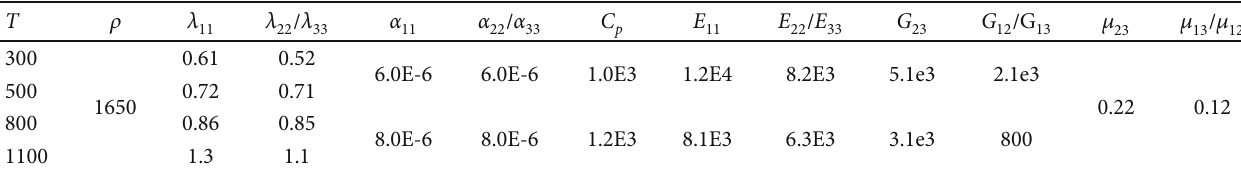
Table 2: Material properties of silica-phenolic composite.